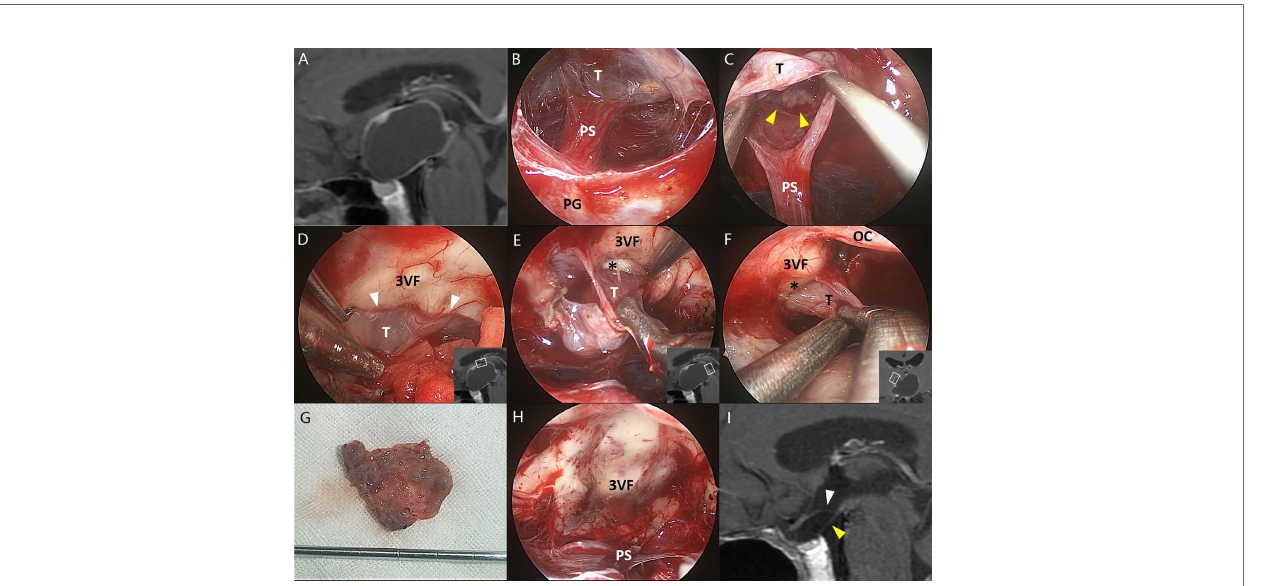
FIGURE 1 | Illustrative endonasal case 1 clarifying the tumor – ventricle relationship. In (A) , preoperative MRI shows that the CP mainly occupies the third ventricle chamber. In (B) , intraoperative photograph indicates the intact pituitary stalk beneath the tumor. In (C) , a clear plane of dissection (yellow arrowhead) was identi fi ed at the tumor – infundibulum interface. In (D) , the top portion of the tumor was easily stripped away from the third ventricle fl oor through a cleavage pial plane (white arrowhead). In (E, F) , the pia mater was absent at some areas of the tumor – ventricle interface (asterisk) while a safe plane of surgical dissection could still be identi fi ed to perform the total tumoral resection without trespassing the third ventricle fl oor. In (G) , the tumor was removed en bloc after circumferential dissection. In (H) , the third ventricle fl oor as well as the pituitary stalk remained intact without any defect after total tumoral removal, suggesting the extraventricular rather than the “ intraventricular ” topography of such tumors. In (I) , postoperative MRI con fi rms the total removal of the tumor and the integrity of the third ventricle fl oor (white arrowhead) and the pituitary gland (yellow arrowhead). 3VF, the third ventricle fl oor; OC, optic chiasm; PG, pituitary gland; PS, pituitary stalk; T,